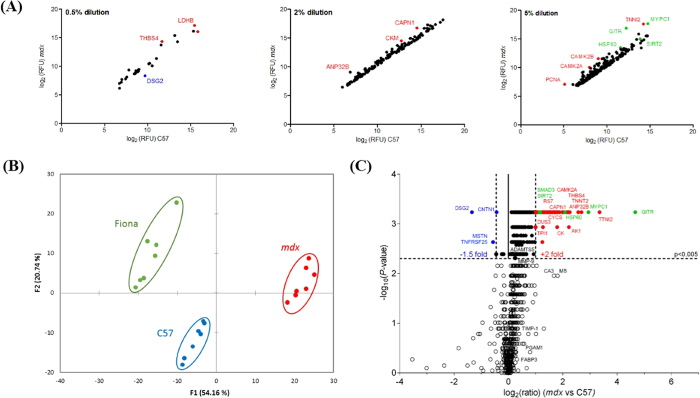
Identification of protein biomarkers in dystrophic serum.Serum samples from C57, mdx and Fiona mice were analysed using the SOMAscan methodology. (A) Scatter plots showing abundance of differentially expressed protein by dilution groups. (B) Principal components analysis (the first two components representing 74.9% of the data are shown). (C) Volcano plot visualizing significant protein changes in mdx serum determined by Mann-Whitney U test (p < 0.005). Red indicates up-regulated protein (>2.0 fold) previously described as potential mdx/DMD serological biomarkers. Blue indicates down-regulated proteins (<0.70 fold) and green are newly discovered markers with a >2.0 fold abundance in dystrophic serum.